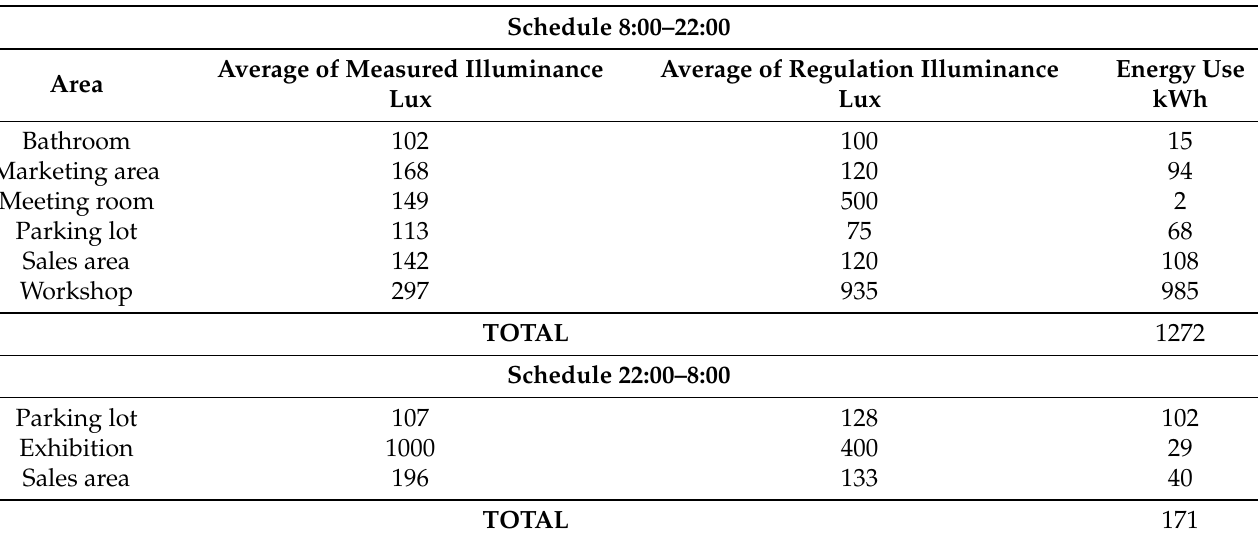
Table A6. Inventory of